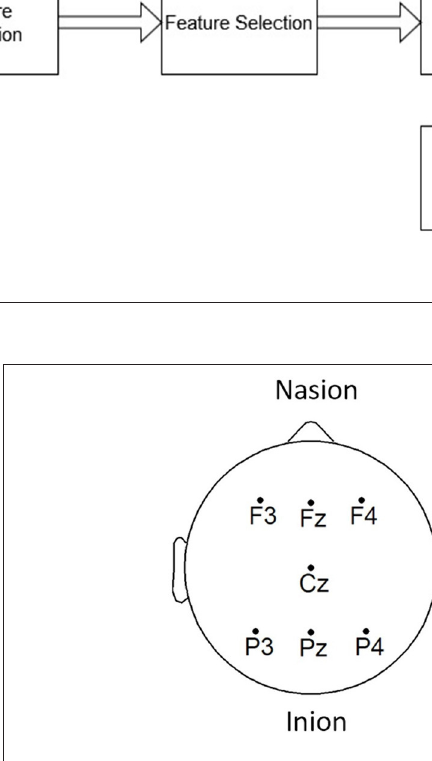
FIGURE 2 | EEG electrode placement, adapted from Cassani et al.